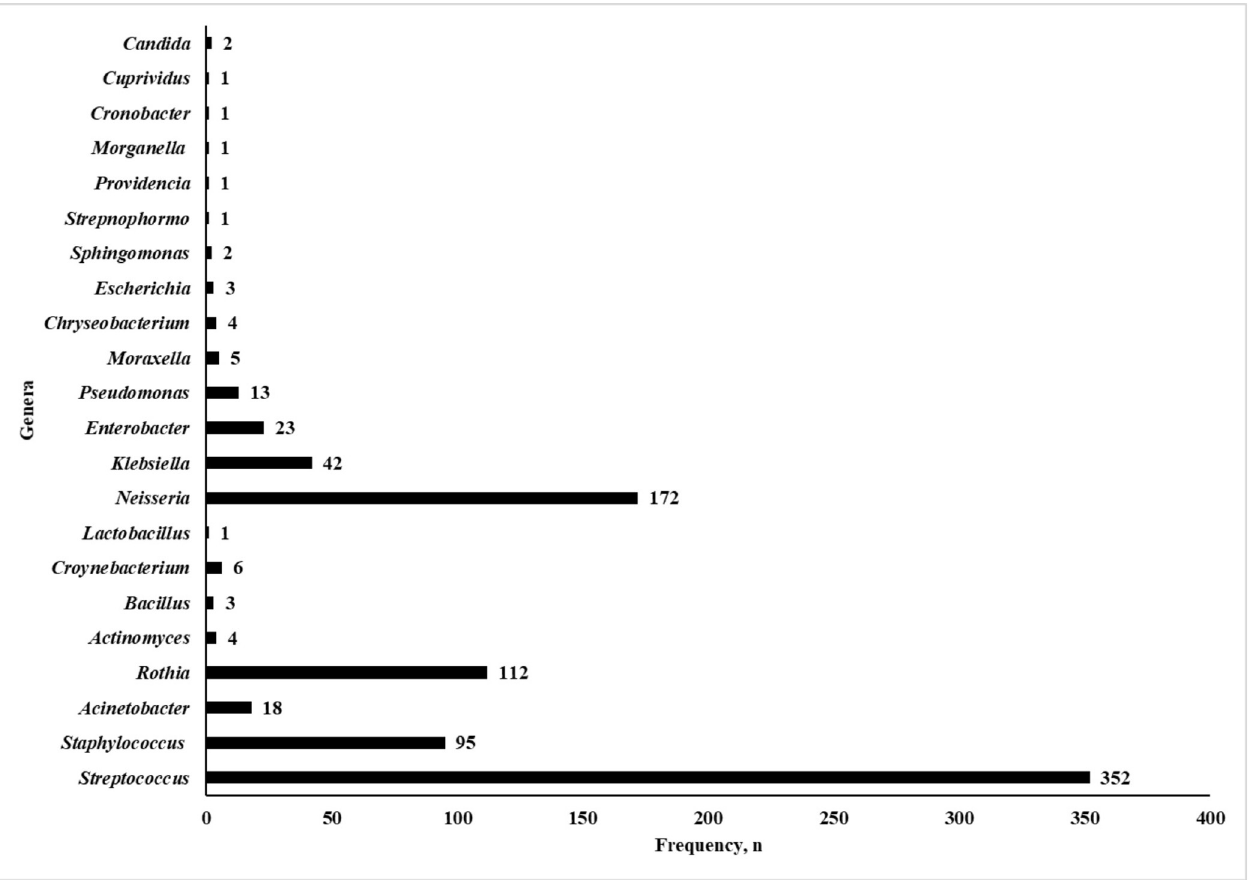
Fig 1. Frequency of genera with non-repetitive isolates found in AP patients’